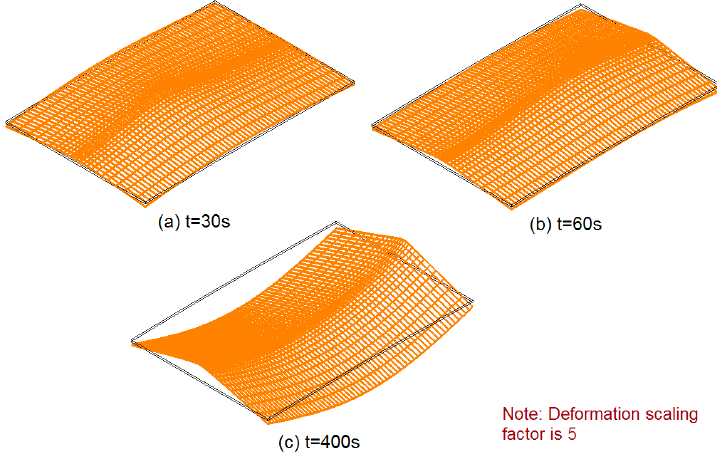
Figure 9. 3D plots of distorted plate by simulation.